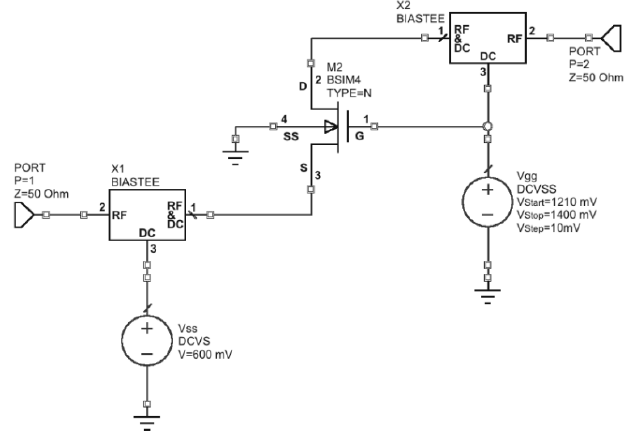
Figure 11. Common gate (CG) stage schematic circuit used for characterization.